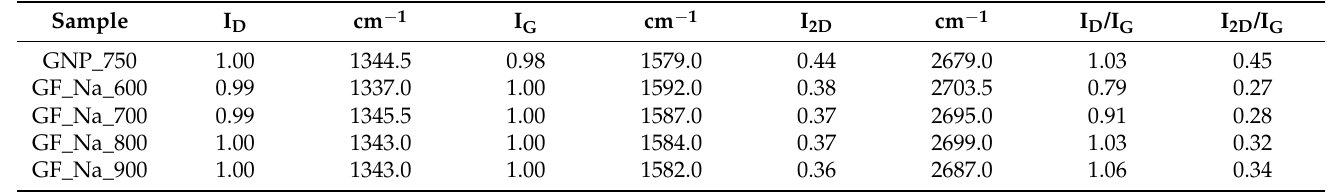
Table 4. Antioxidant activity (RSA%) of graphene samples.